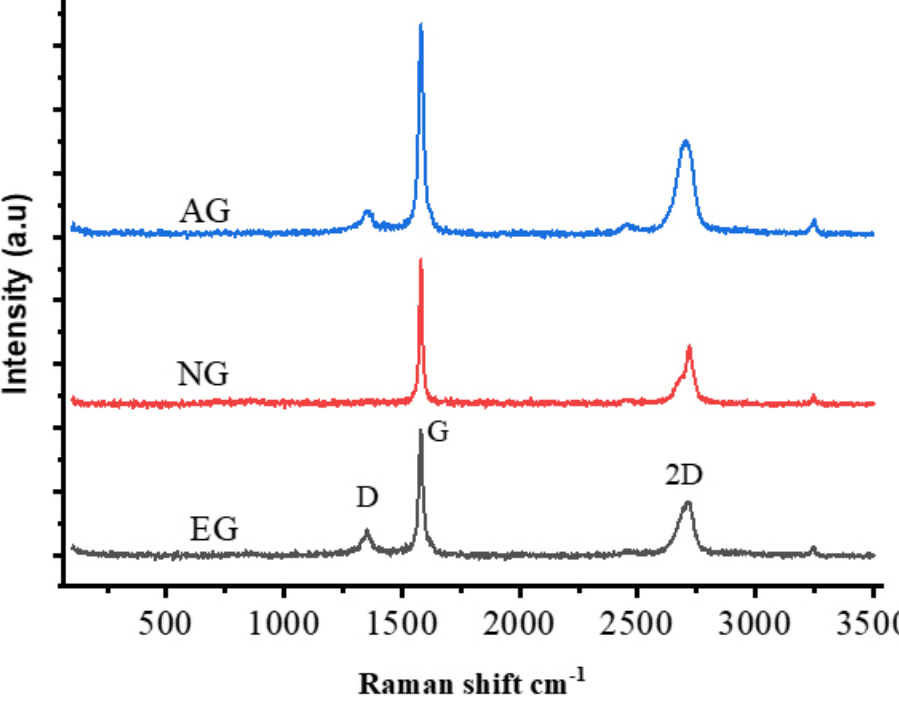
Figure 4. Raman spectra of AG, NG and EG.